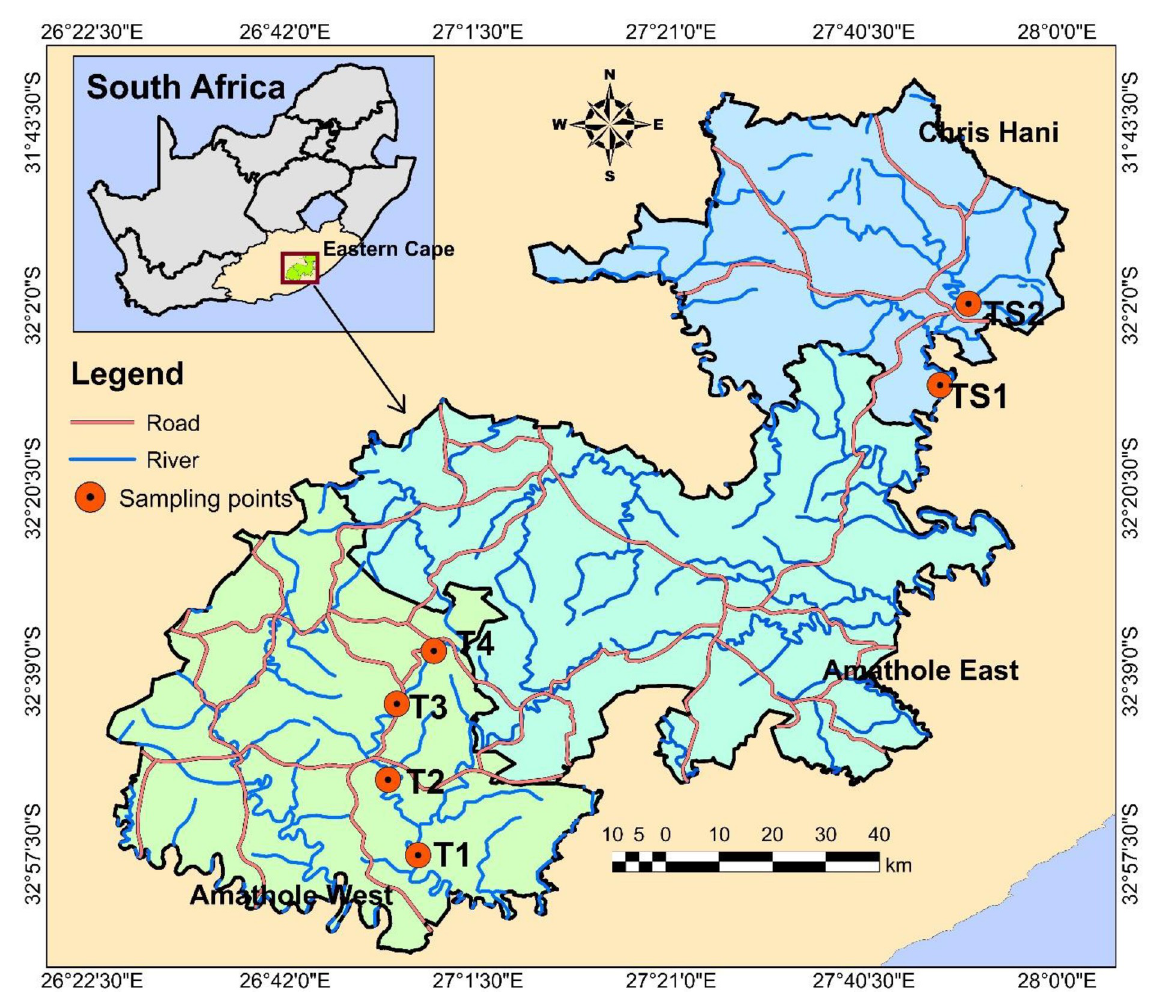
Fig 1. Location of sampling sites in Tyhume and Tsomo River. Site codes TS1 represents Bongweni, and TS2 represents Tsomo, which are sampling points along the Tsomo river in Chris Hani District Municipality. Site codes T1 –T4 represents Hala, Khayalethu, Sinakanaka, and Alice, respectively, which are sampling points along the Tyhume river in Amathole District